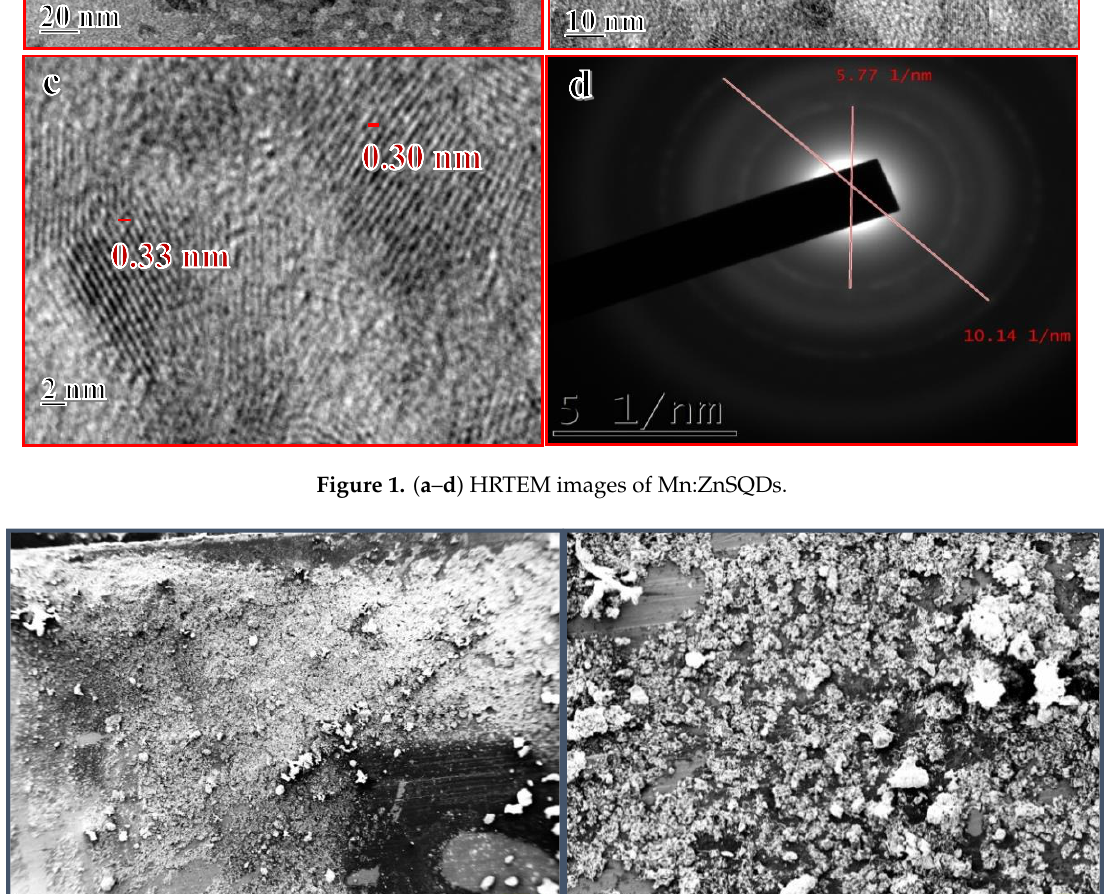
Figure 1. ( a – d ) HRTEM images of Mn:ZnSQDs.